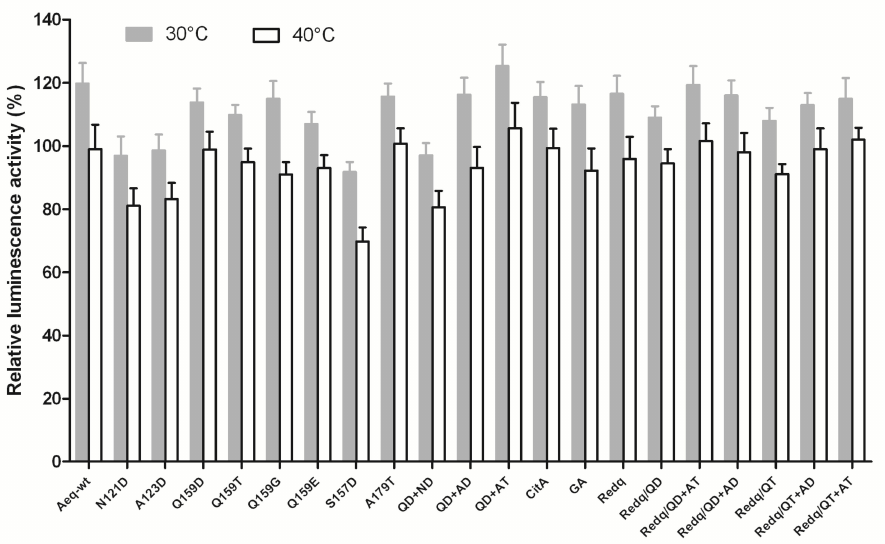
Figure 5. Thermostability of aequorin mutants, GA, CitA, redquorin (Redq) and Redq mutants. Photoproteins were purified and reconstituted with CLZ-f. The samples were incubated at room temperature (20–24 ◦ C) for 15 min before measuring total luminescence on a first aliquot using saturating Ca 2 + solution. Samples were then incubated at indicated temperatures for 30 min before measuring total luminescence on a second aliquot. The relative bioluminescence activity at each temperature was calculated by the ratio 2nd counts (at target T ◦ C) / 1st counts (at initial room T ◦ C) multiplied by 100. Bars represent mean ± SD , with n between 3 and 5.